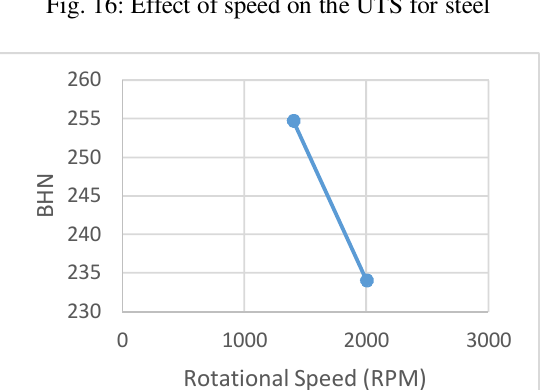
Fig. 16: Effect of speed on the UTS for steel